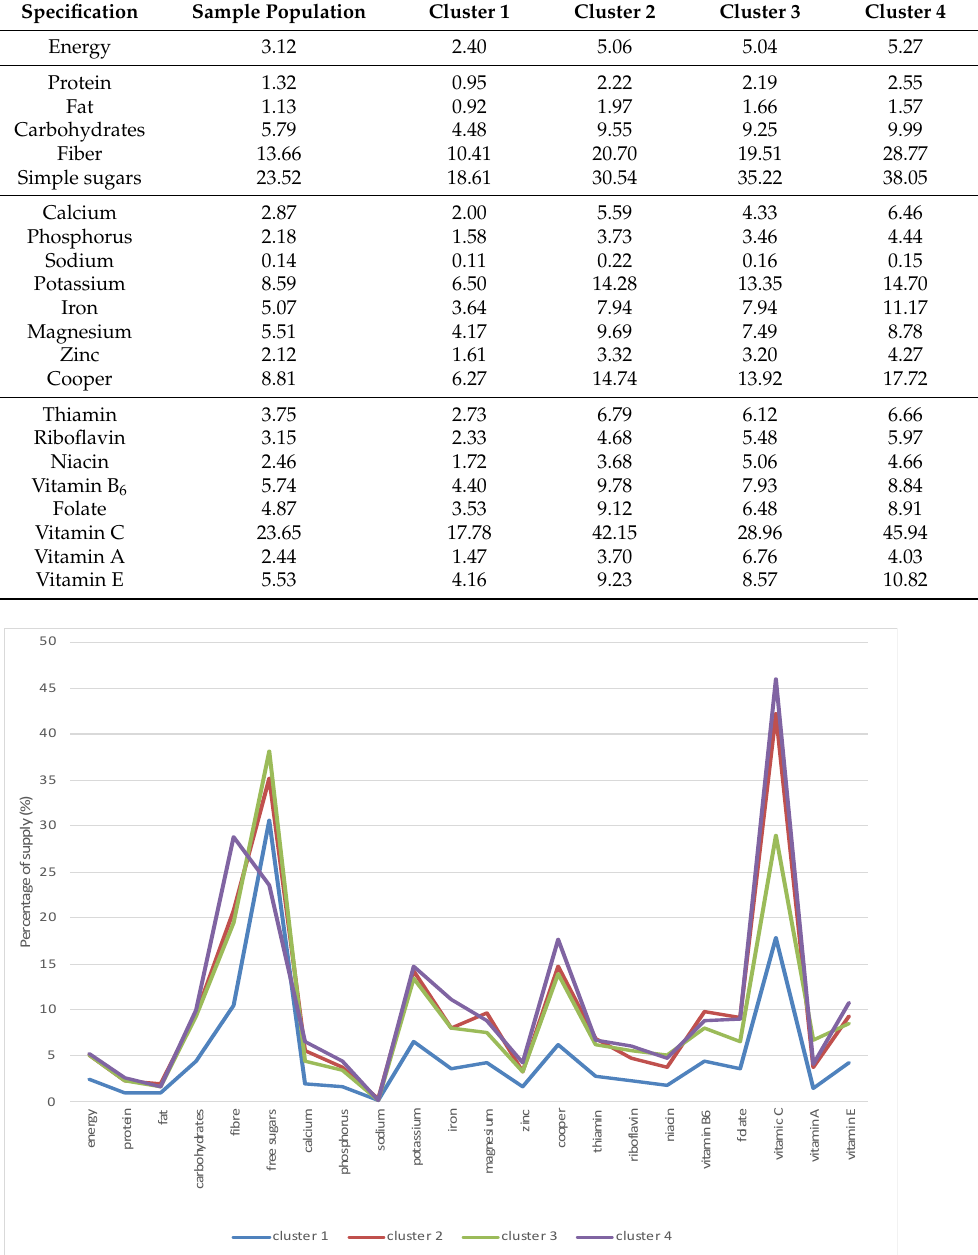
Table 6. Cluster analysis: supply (in %) of energy and nutrients from fruit and fruit products.